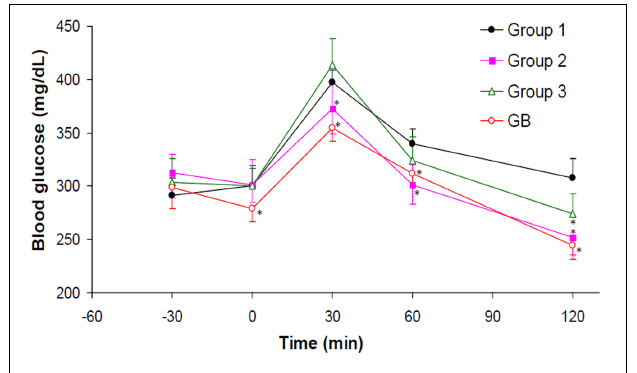
FIGURE 7 | Oral Glucose Tolerance Test (OGTT) of experimental groups. Data = mean ± SD ; n = 6. ∗ Values are significantly ( p < 0.05) different compared to group 1. Group 1: diabetic control (distilled water); Group 2: diabetic rats + crude extract; Group 3: diabetic rats + dichloromethane fraction; GB: diabetic rats + glibenclamide.